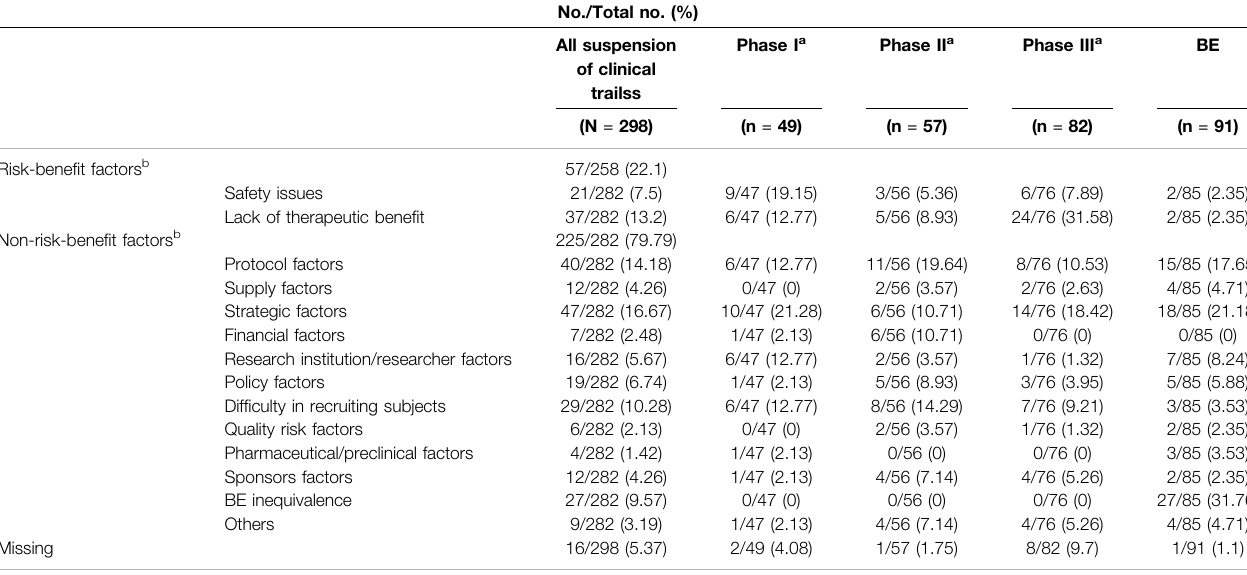
TABLE 2 | Analysis of reasons for suspensions overall and clinical trial phases.